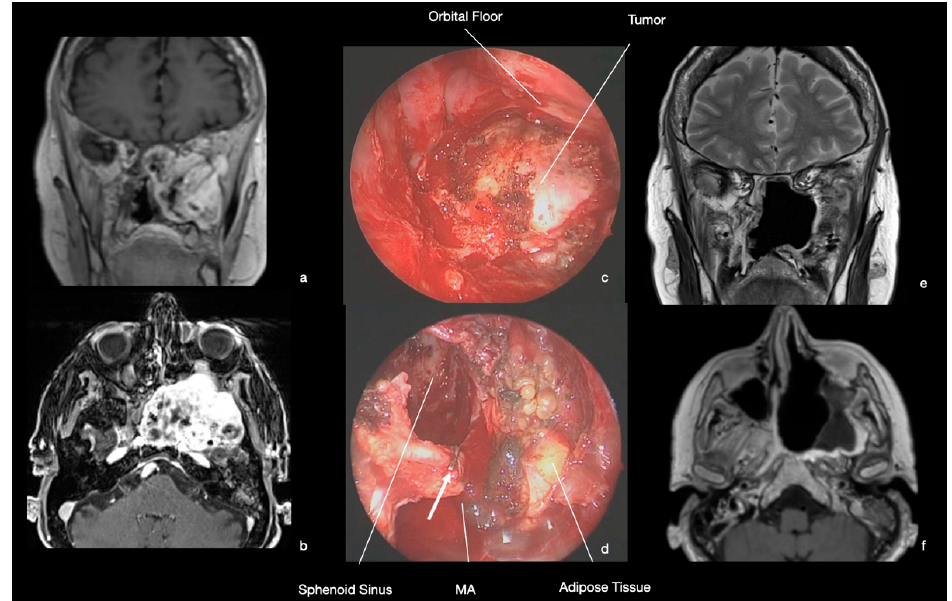
Figure 6. MRI and intraoperative endoscopic images (0° scope). ( a , b ) MRI. T1 w-sequence with contrast agent. A large mass extending in the left PPF and ITF was demonstrated. The floor of the orbit was pushed superiorly, with no suspect of periorbit infiltration. ( c ) Intra-operative image. After medial maxillectomy and resection of the posterior wall of maxillary sinus, the soft tumor was progressively resected. It was possible to cleave the lesion from the orbital floor. ( d ) Intra-operative image. At the end of the surgery, the tumor was completely resected with preservation of PPF anatomical structures. The maxillary artery (MA) has been identified and clipped (white arrow) during the tumor removal. ( e , f ) MRI. Coronal and axial view. T2 w-sequence and T1 w-sequence with contrast agent. Radical tumor resection was confirmed with no surgical complications.